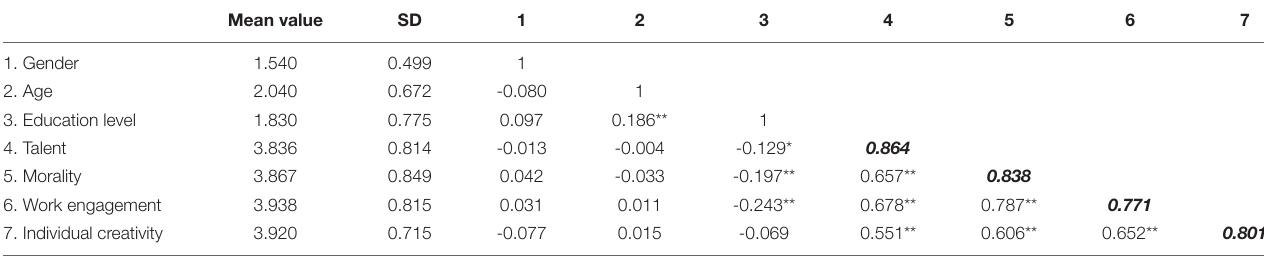
TABLE 1 | Correlation coefficient matrix.